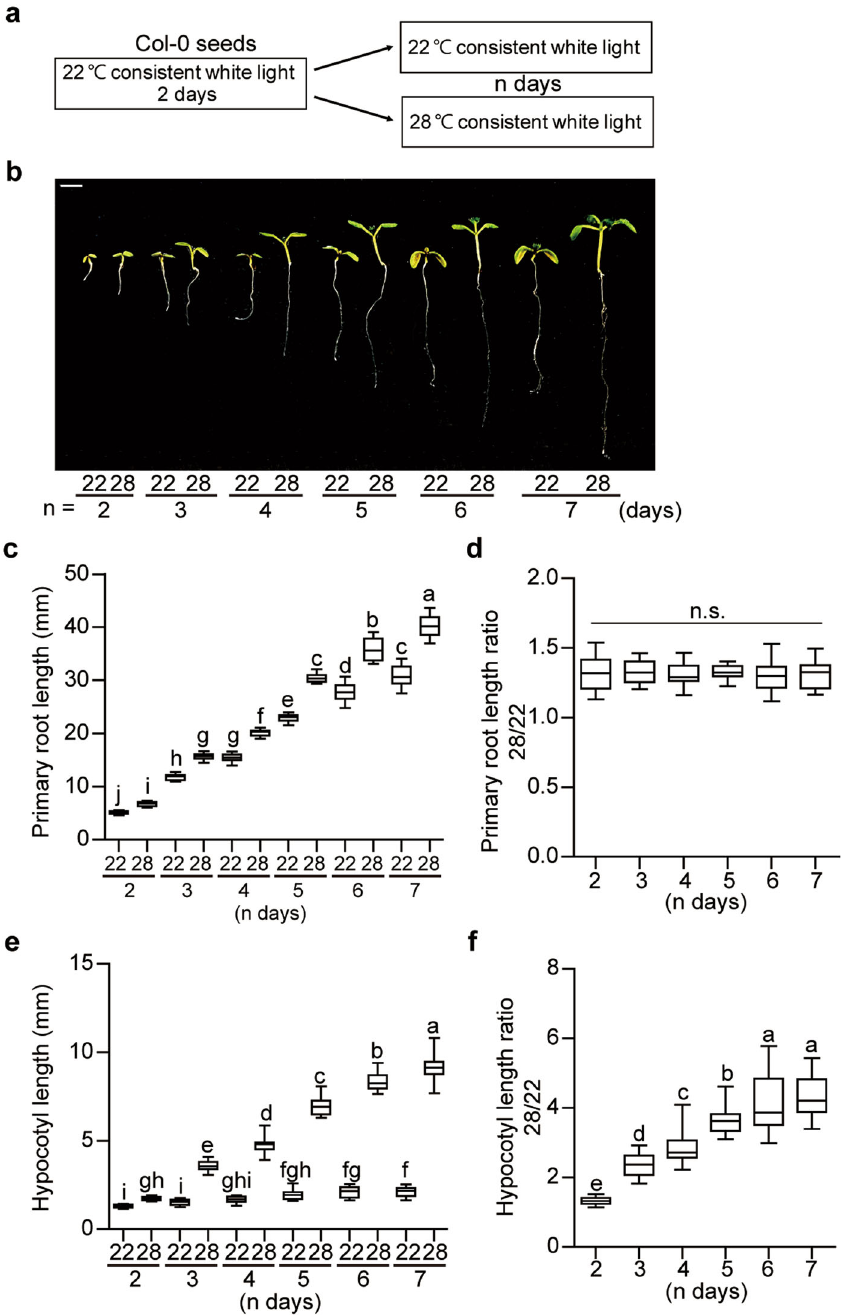
Fig. 1 Altered seedling architecture at high ambient temperature. a Simpli fi ed experimental condition used in this study for phenotypic analysis. b Photograph showing seedling phenotypes of Columbia-0 grown at 22 °C and 28 °C over time. Seedlings were grown for two days in continuous white light at 22 °C and then either kept at 22 °C or transferred to 28 °C for additional n days before being photographed. The scale bar represents 2 mm. c , e Bar graphs show the primary root ( c ) or hypocotyl ( e ) lengths for seedlings grown under conditions described in ( a ). d , f For the length ratio 28/22, primary root or hypocotyl length at 28 °C is divided by those values at 22 °C. The letters a – j indicate statistically signi fi cant differences between means of primary root or hypocotyl lengths ( n = 15, P < 0.05) based on one-way ANOVA analyses with Tukey ’ s HSD test. n.s. stands for not signi fi cant. For the box and whisker plots in ( c – f ), the boxes represent from the 25th to the 75th percentile and the bars equal the median values. The source data underlying the root ( c , d ) and hypocotyl ( e , f ) measurements are provided in the Source data fi